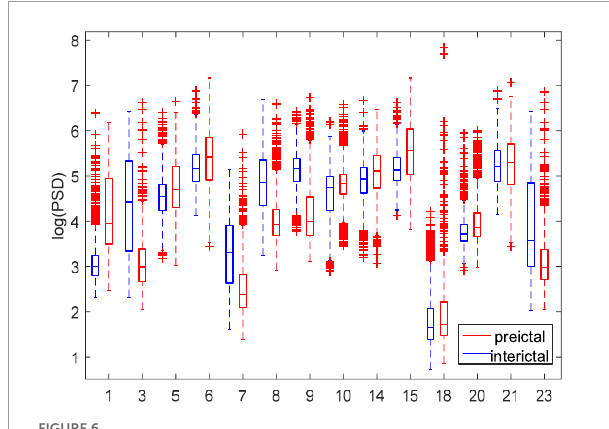
FIGURE6 Comparison of PSD between preictal and interictal states for 14 patients in the CHB-MIT dataset.